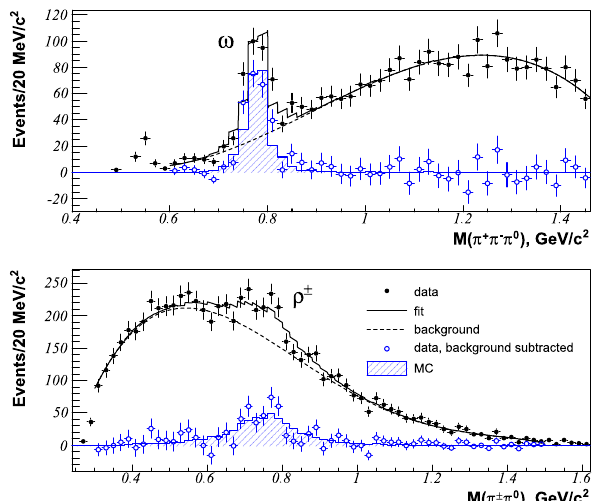
Fig. 4 Masses of π + π − π 0 and π ± π 0 in selected signal events of J /ψ → K + K − π + π − π 0 decays. Close circles are experimental data, black solid lines are the sums of MC histograms for the correspond- ing decays through resonances (hatched histograms) and backgrounds (dashedlines),opencirclesarethedataaftersubtractingofbackgrounds